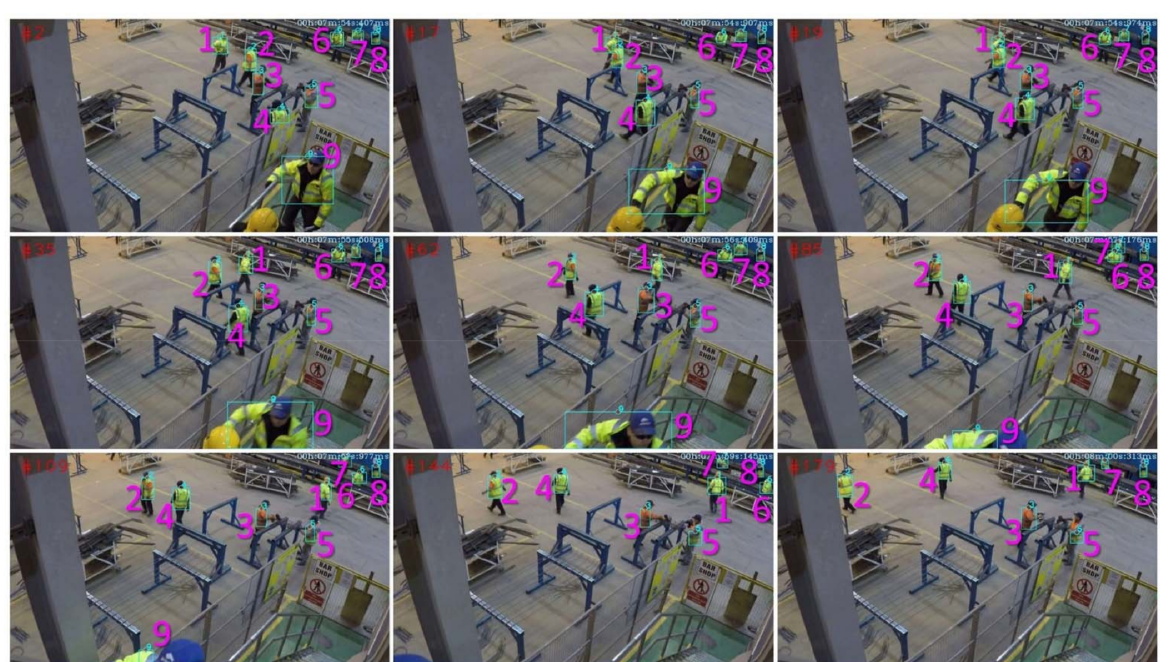
Figure 5. Multiple worker tracking